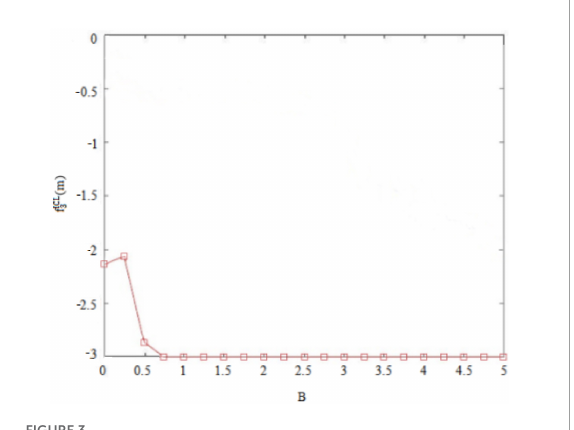
FIGURE3 Deviant innovative behaviors and perceived benefits of low risk-taking traits of “insider